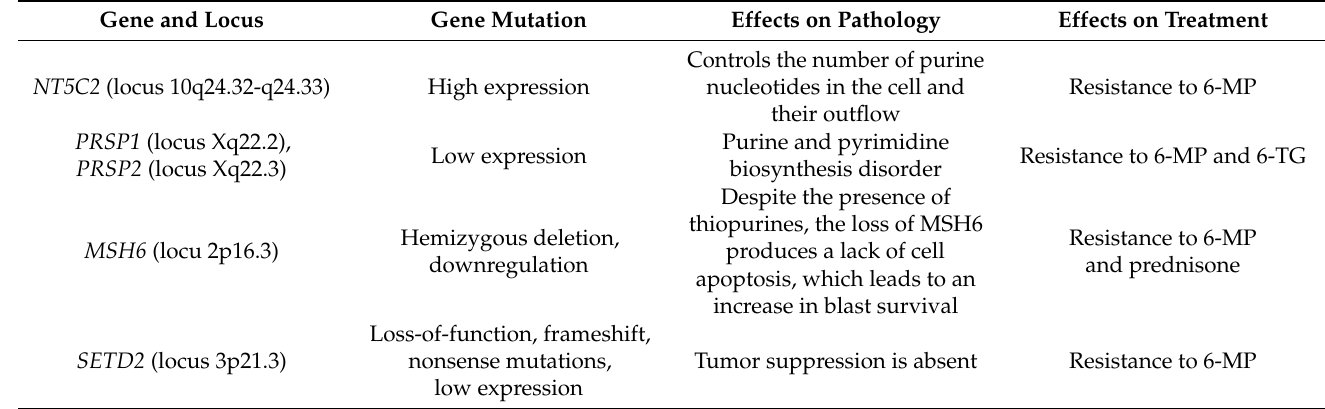
Table 3. Characteristics of genes, their mutations, and pathological and therapeutic effects responsible for resistance to steroids and purine